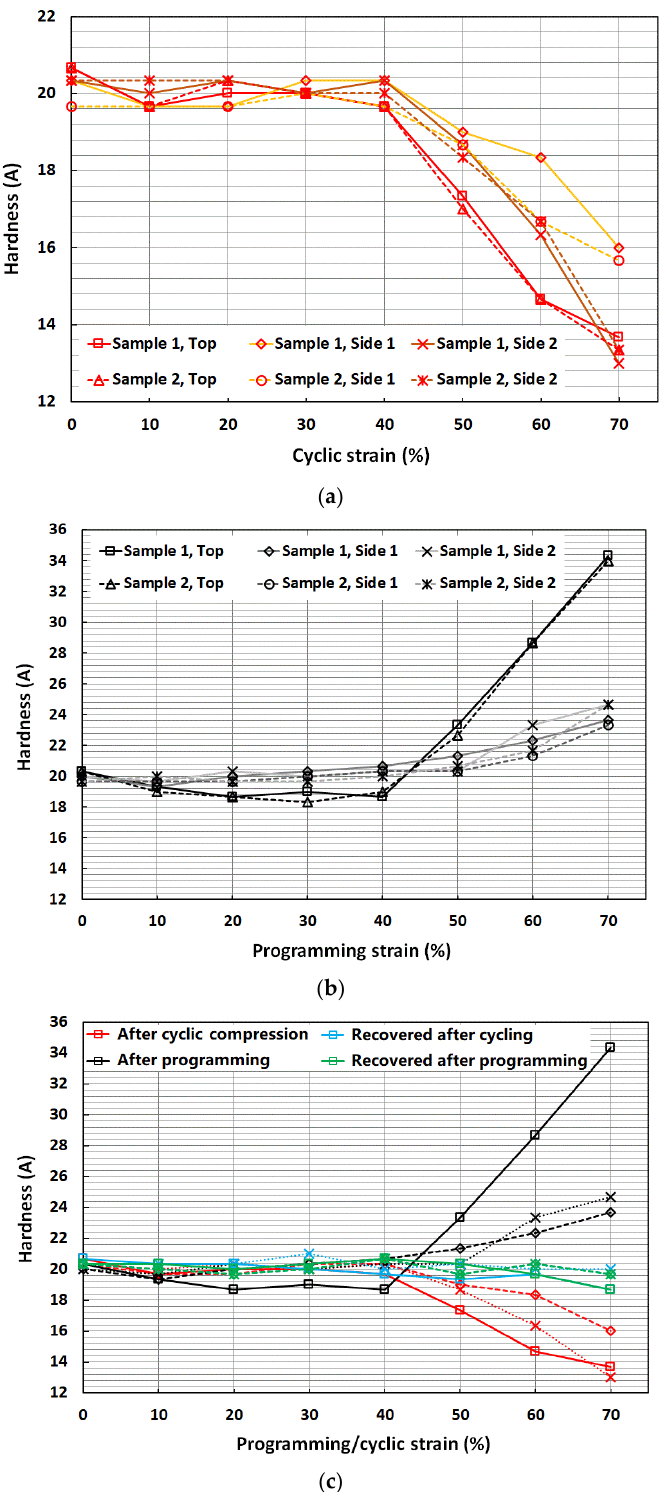
Figure 5. Shore hardness (average) of two cuboid samples (same color) on three different sides ( a ) after cyclic compression on the top surface; ( b ) after programming (compression) on the top surface. ( c ) Comparison of four different types of tests (results of one representative sample. Solid line: Top surface; dashed line: Side 1; dotted line: Side